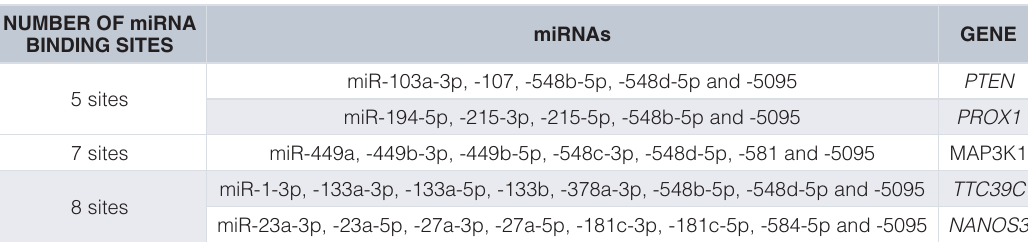
Table 6. Gene associated a more five binding sites of miRNAs.